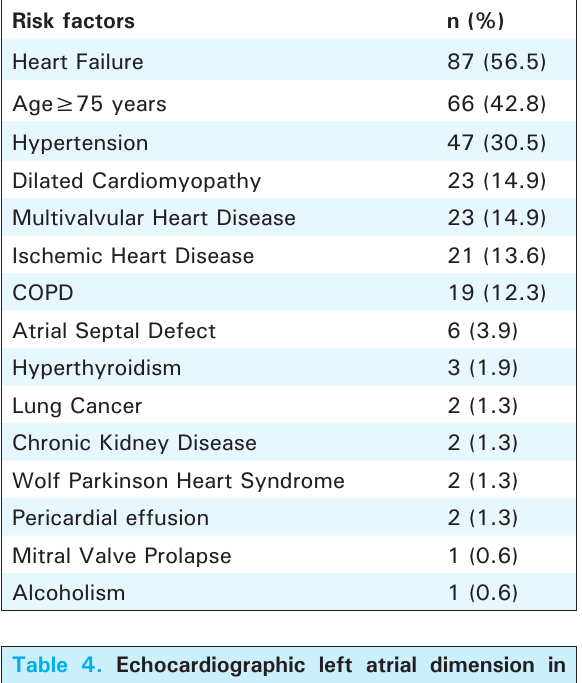
Table 3. Risk factors in Nonvalvular Atrial Fibrillation.